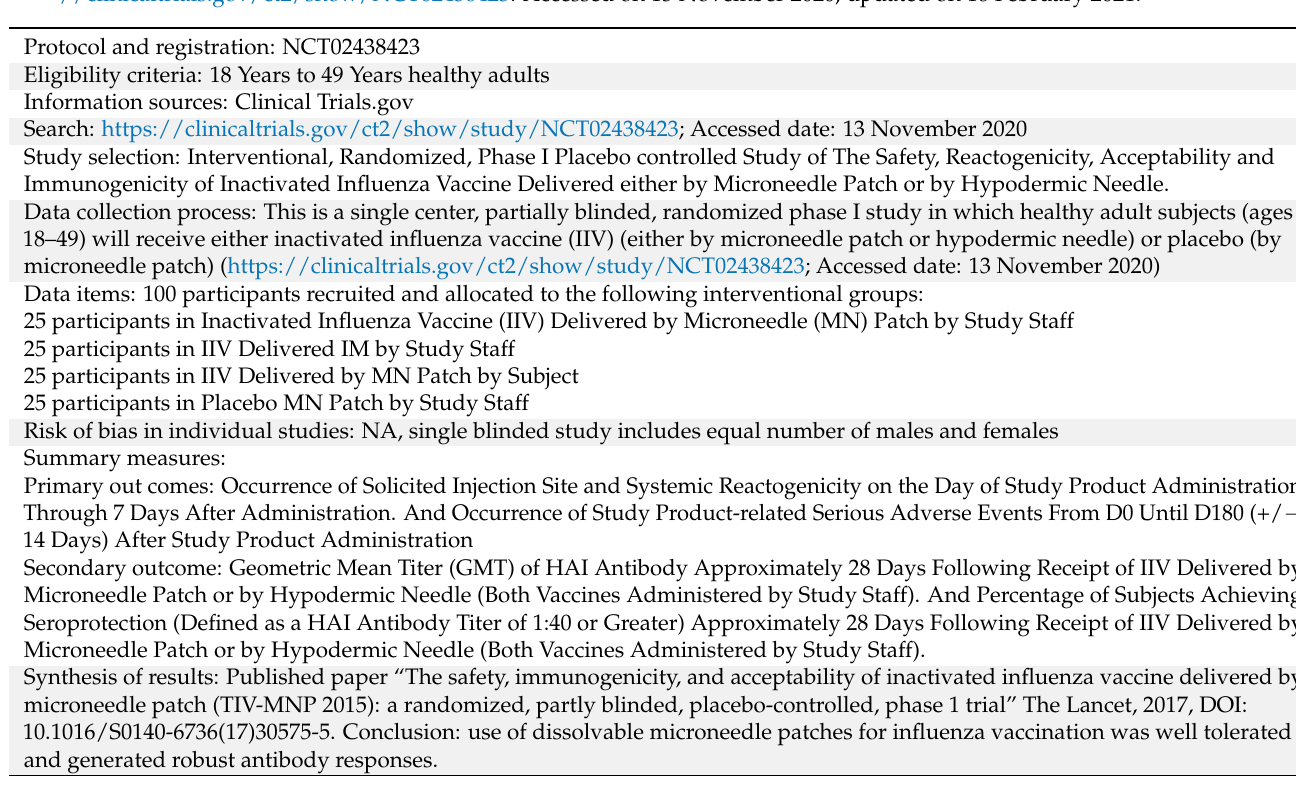
Table A2. First study: Inactivated Influenza Vaccine Delivered by Microneedle Patch or by Hypodermic Needle. https: